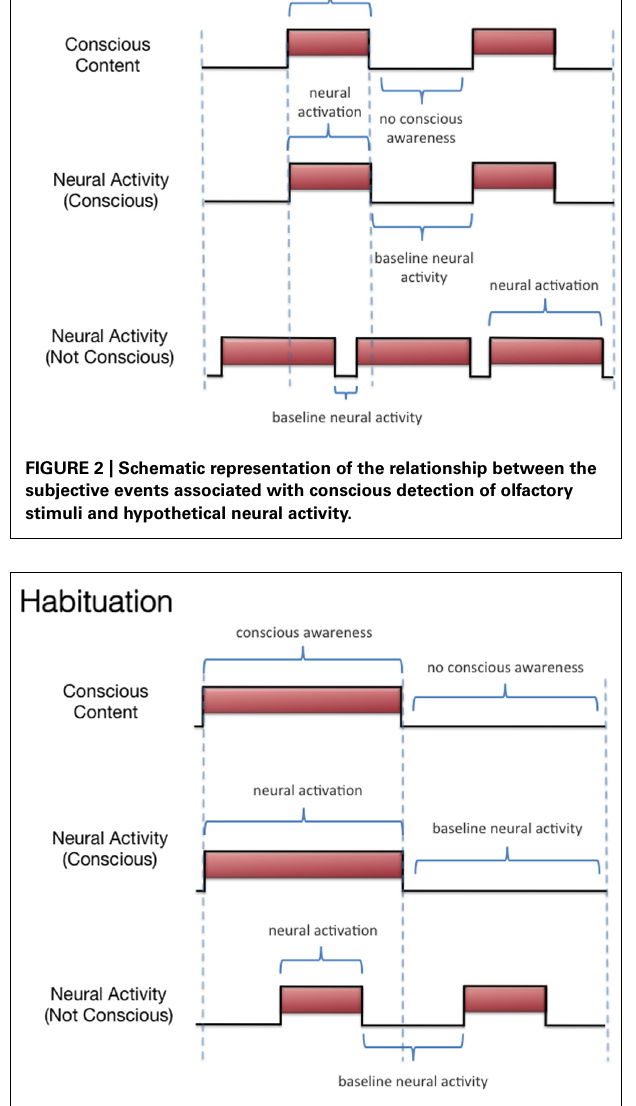
FIGURE 3 | Schematic representation of the relationship between hypothetical neural activity and the subjective events associated with habituation of olfactory